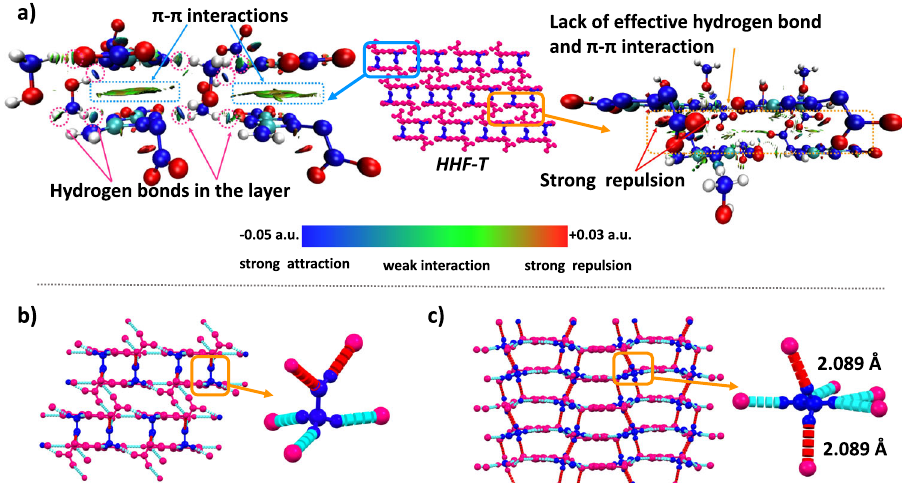
Fig. 6 | The weak interactions in HHF-T. a Noncovalent interaction (NCI) plots of HHF-T. b 3D network of HHF-T, and the hydrogen bonded environment of the hydroxylamine cation; c 3D network of HHF-F, and the hydrogen bonded